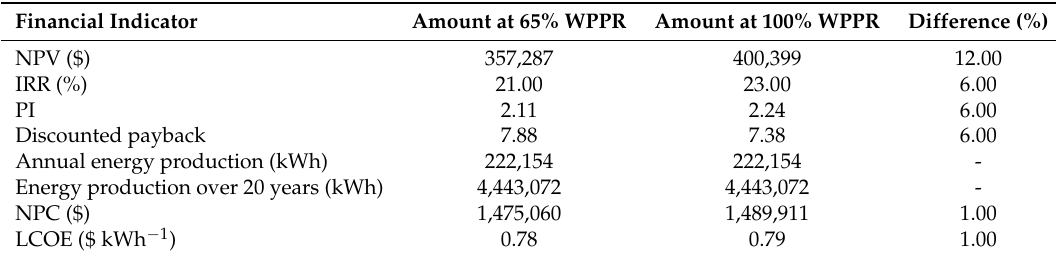
Table 11. Summary of key indicators used in the financial